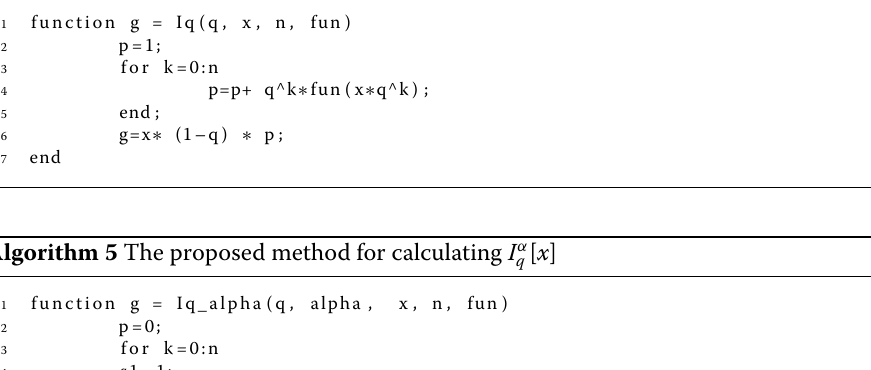
Algorithm 4 The proposed method for calculating